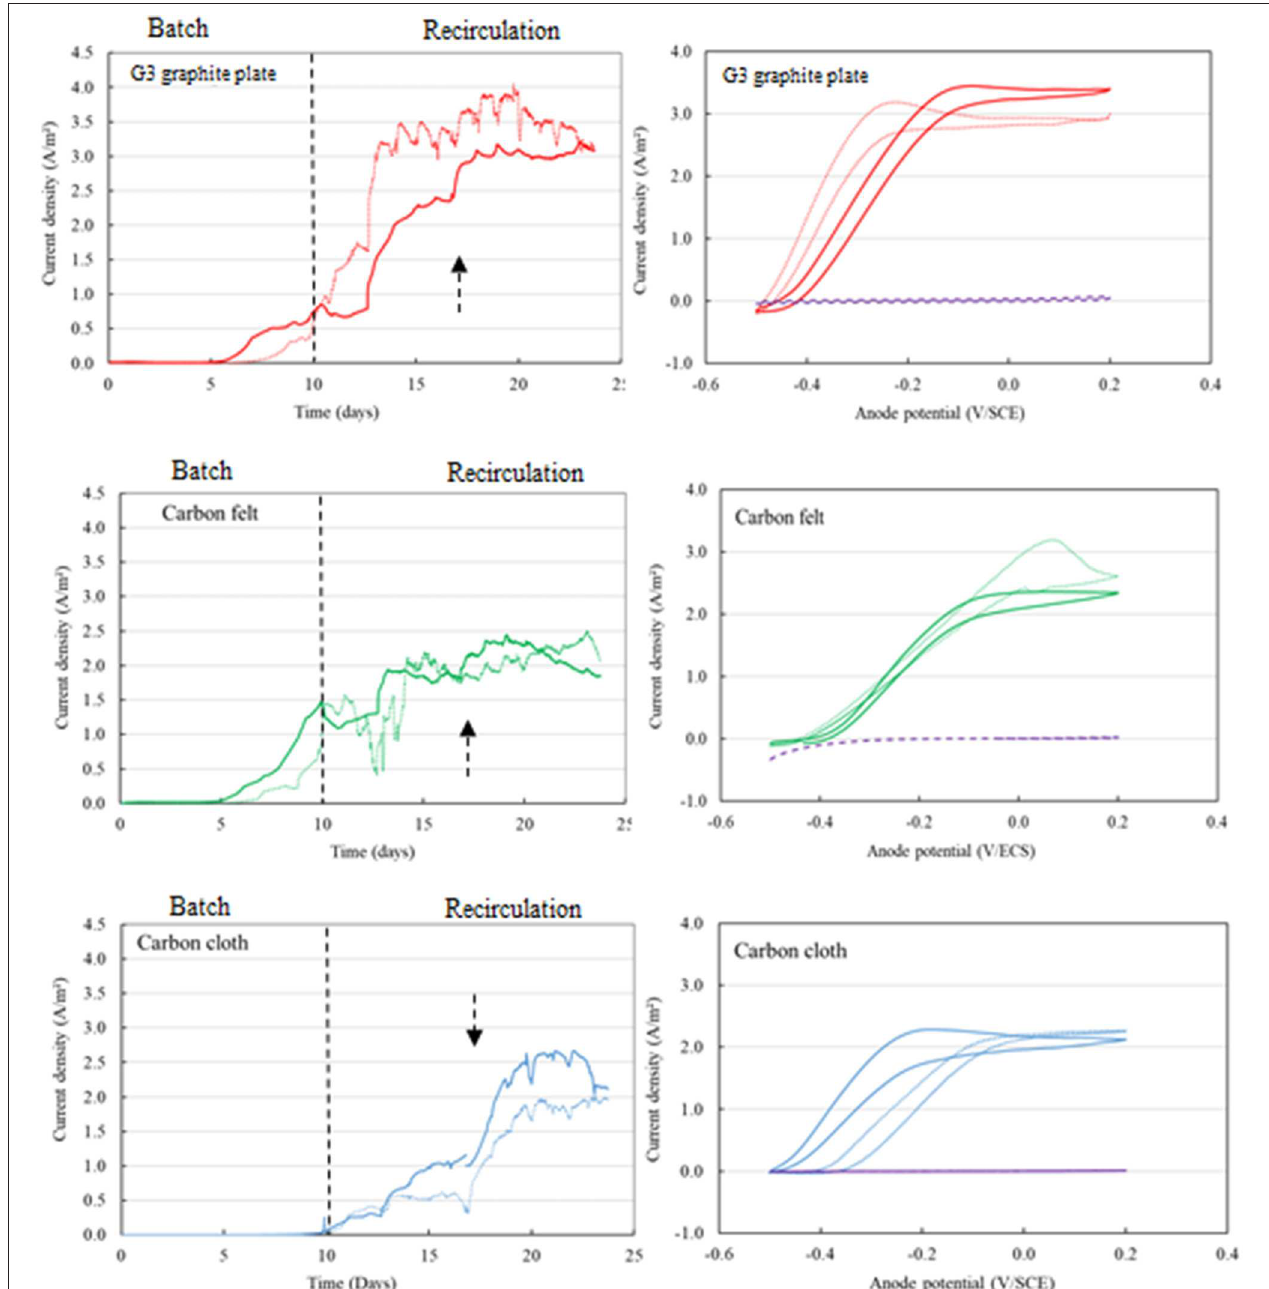
FIGURE 2 | (Left) Chronoamperometries for dWW-fed bioanodes formed on G3 graphite, CF, and CC electrodes. For the first 10 days the reactors are conducted in batch mode and are then switched to recirculating mode (dashed line) with a 2L tank of hydrolyzed dWW that is renewed at day 17 (dashed arrow). (Right) Cyclic voltammetries performed in dWW with a stable COD concentration under turnover conditions at 1 mV/s, at the beginning of the experiment (dashed line) and after 24 days of experiment (full and dotted lines). Duplicates were conducted for each electrode material.